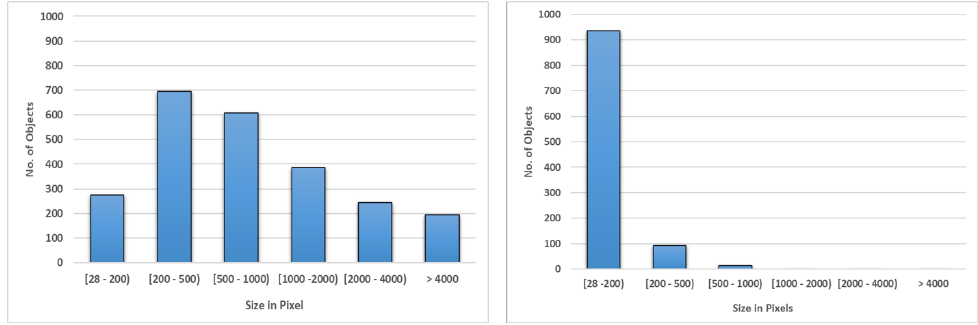
Figure 2. Bird size statistics from Klim ( left ) and Skagen ( right )